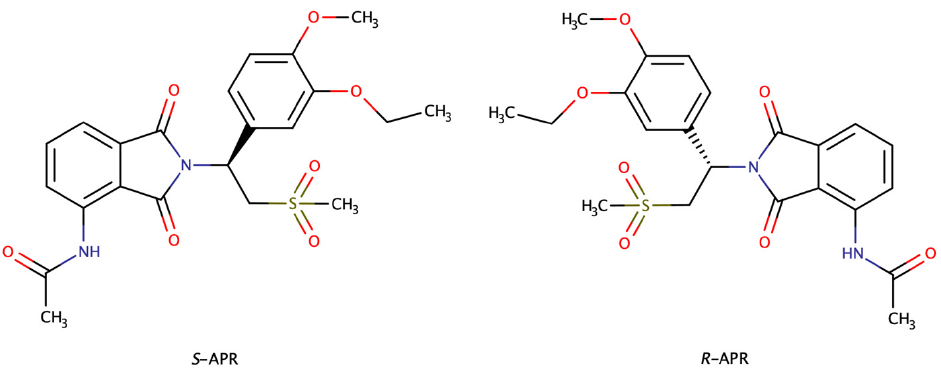
Figure 1. Constitutional formulas of APR enantiomers.